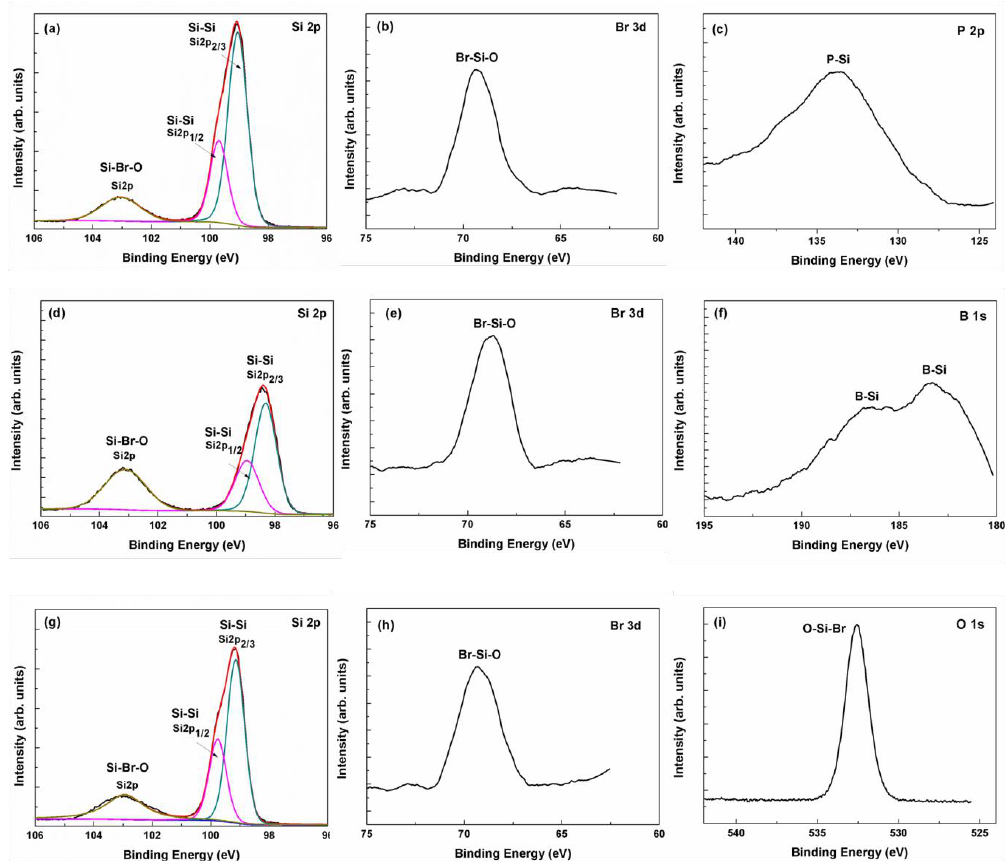
Figure 5. XPS spectra of ( a , d , g ) Si 2p; ( b , e , h ) Br 3d; ( c ) P 2p; ( f ) B 1s; ( i ) O 1s. ( a – c ) n-type polysilicon,